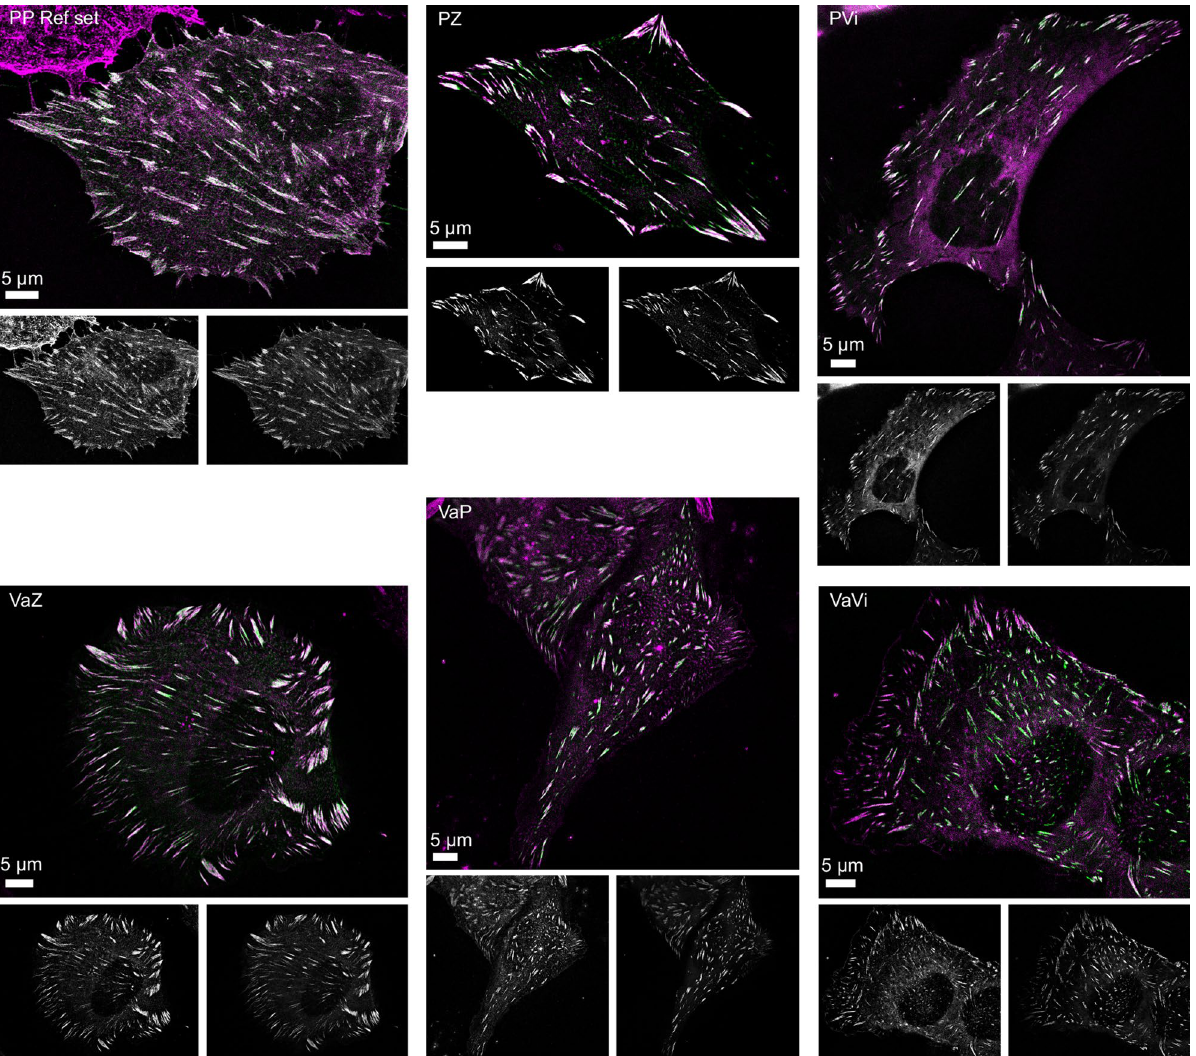
Figure 2. Representative SIM images of U2OS cells co-expressing FA protein pairs. Representative SIM images of U2OS cells co-expressing the indicated protein combinations (P: Paxillin, Vi: Vinculin, Va: VASP, Z: Zyxin), where the first is C-terminally mCherry-tagged and the second is C-terminally GFP-tagged. In the merged image the red channel is pseudocoloured magenta, the grayscale images below each merged image show the red (left) and green (right) channels separately. For visualisation purposes the contrast is enhanced, note that all data analysis is performed on images with unadjusted contrast magnitude of the differences (see Materials and Methods for scale details). The VASP/zyxin protein set showed a distribution similar to the pax/pax reference histograms, again indicating neither protein protruded significantly at either FA end (Fig. 4a). In the data sets including paxillin (Fig. 4b–d), the relative frequency of FAs with the combination of none to very short head and tail lengths was decreased compared to the pax/pax reference histo- grams (cyan clusters at the centres of the histograms). The frequency of FAs with paxillin heads in combination with zyxin, vinculin or VASP tails was increased (magenta clusters in the respective quadrants of the histograms). The 2D-histogram of the VASP/vinculin set (Fig. 4e) clearly shows that the frequency of FAs with short head and tail protrusions is reduced (cyan cluster at the centre of the histogram), but the observed increases are small (no dark magenta) and they do not seem to cluster anywhere in the histogram. This is to be expected because neither protein extended significantly at the FA head, and only at the tail vinculin protruded significantly (Fig. 3f). Because there is no preference for either protein at the head, the increased frequency of FAs with vinculin tails is distributed over a large part of the lower half of the histogram, not clustered in a particular quadrant as is the case for the protein sets with paxillin, making the differences at individual bins less pronounced. FA heads shorten and tails lengthen during scattering. Next, we examined the effect of HGF- induced scattering on the distribution of paxillin and zyxin along FAs. HGF, also known as the scattering factor, induces a scattering response in epithelial cells, including in U2OS cells 35,38–40 . During scattering cells display